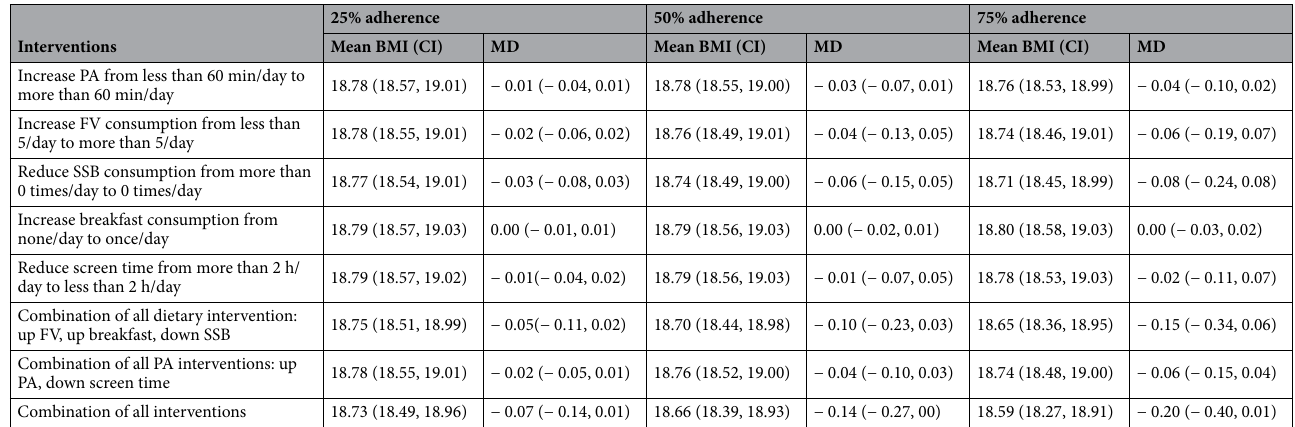
Table 3. Mean BMI at age 13 under interventions at age 11 and impact of interventions at different adherence levels in terms of mean differences. Using 2000 bootstrap samples, marginal structural model. Outcome of interest = BMI at age 13. Adjusted for age, puberty, sex, parental education, BMI at age 11. BMI body mass index, FV fruits and vegetables, MD mean difference, PA physical activity, SSB sugar-sweetened